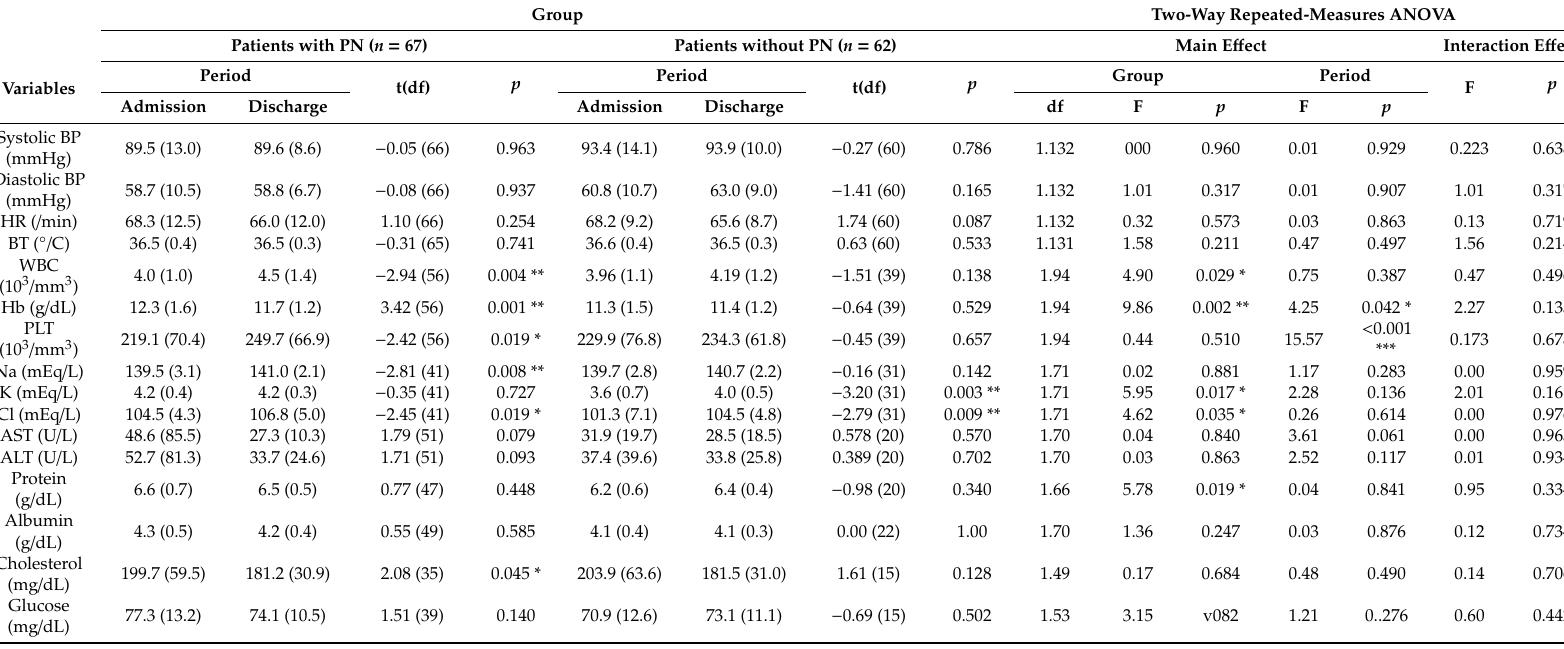
Table 3. Medical parameters of AN patients with and without PN at admission and discharge. Group Two-Way Repeated-Measures ANOVA Patients with PN ( n = 67) Patients without PN ( n = 62) Main E ff ect Interaction E ff